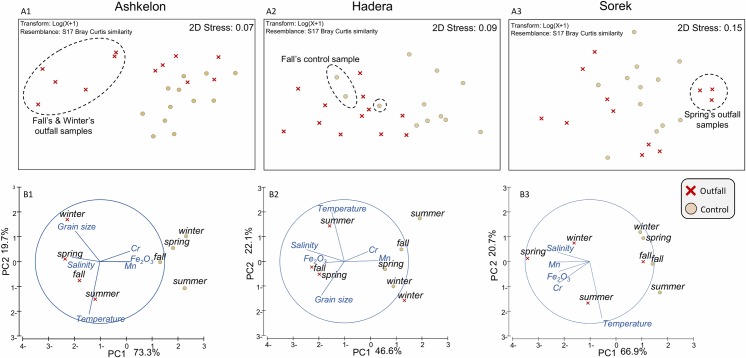
A1-A3. nMDS plots based on foraminiferal assemblages. Show the dissimilarity distance matrix between the outfall and control station at each site. Each mark represents one sample. All replicates are shown. Samples with exceptional abundance or species richness values are circled. B1-B3. PCA plots of the environmental data. The vector presented only if the correlation is > 0.9. The specific variable values for contribution are detailed in Table 3.